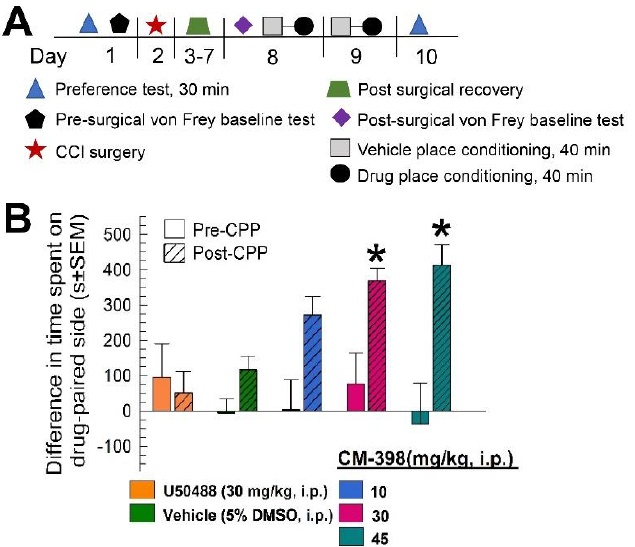
Figure 9. Evaluation of CM-398 in an operant model of antinociception using constrictive nerve injury (CCI)-conditioned place preference (CPP). ( A ) Schematic representation of the CCI/CPP operant model of pain protocol; ( B ) Dose-dependent antinociception of CM-398 following i.p. administration in the mouse CCI/CPP operant pain model. Negative control mice were treated with vehicle (5% DMSO, i.p.; second pair of bars from left) and positive control mice were treated with the kappa opioid agonist U50,488 (leftmost pair of bars). All points represent differences in time spent on the drug-paired side ± SEM tested in 15–20 mice/drug. * = postconditioning response (striped bars) significantly different from matching pre-CPP response (matching open bars), p < 0.05; two-way ANOVA with Sidak’s post hoc